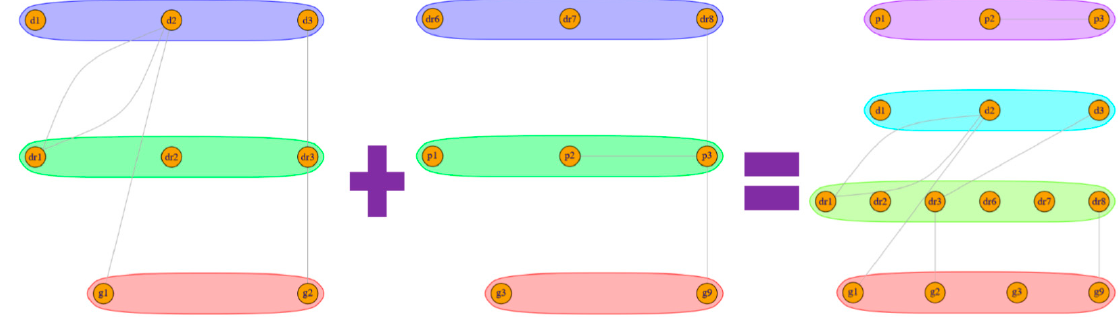
Figure 5. Layer Based Merging.